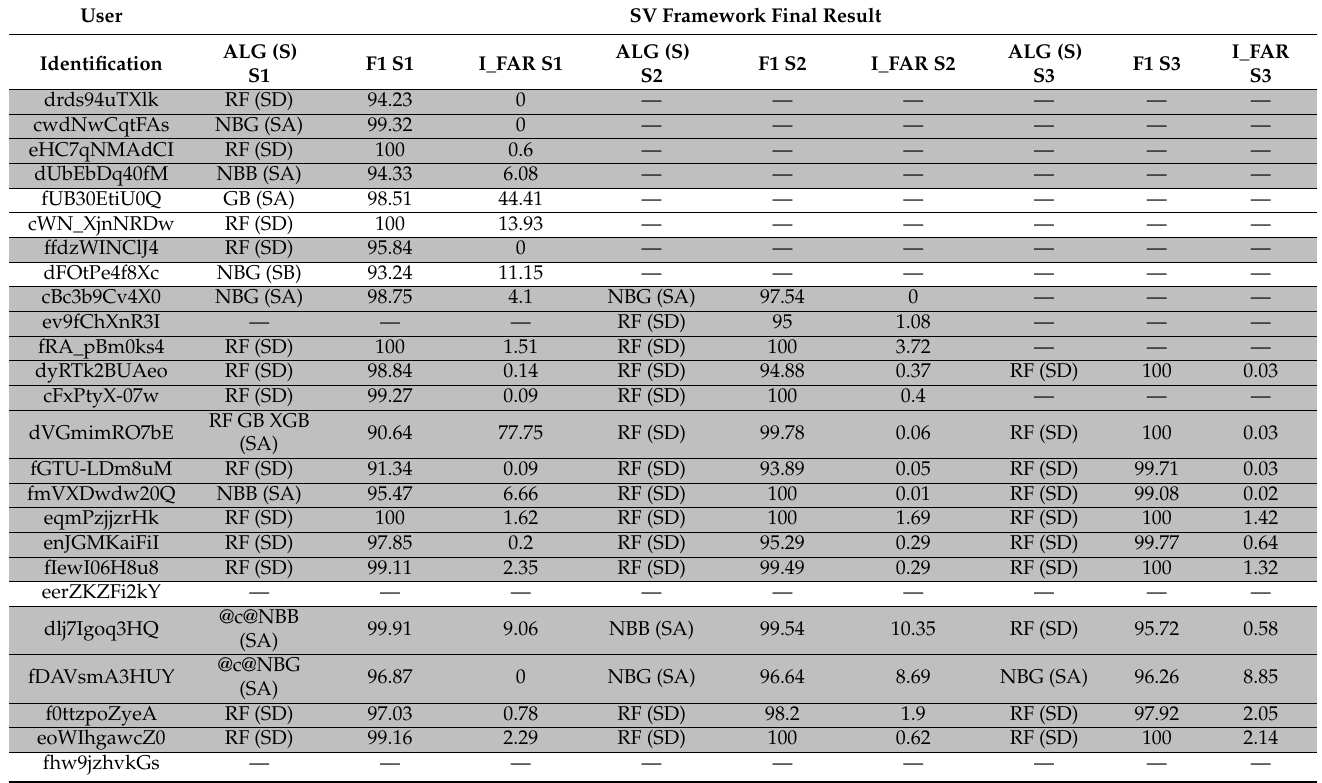
Table 9. Final results for SV framework scenarios.